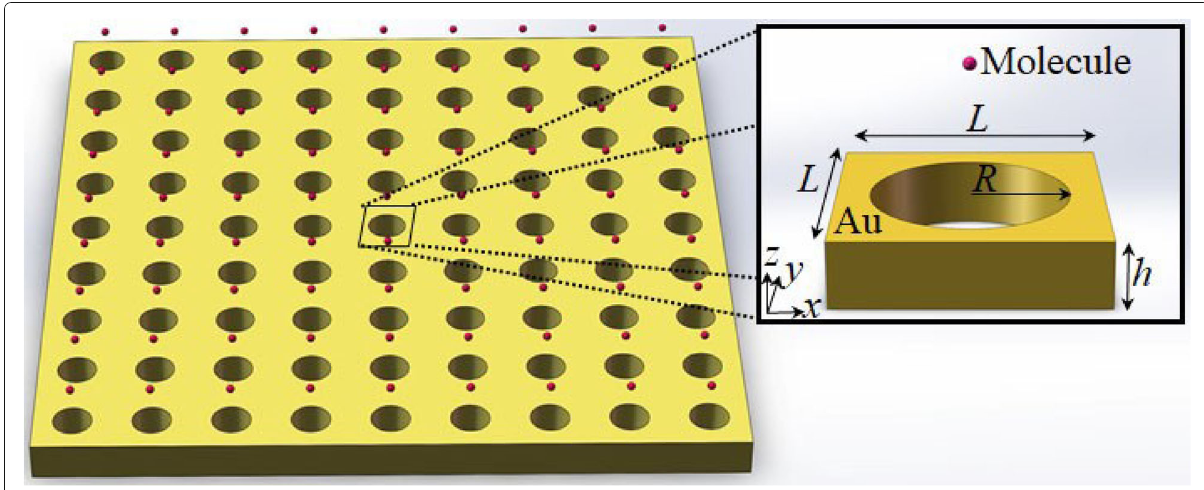
Fig. 5 Schematic diagram of a molecule trapped in the structure